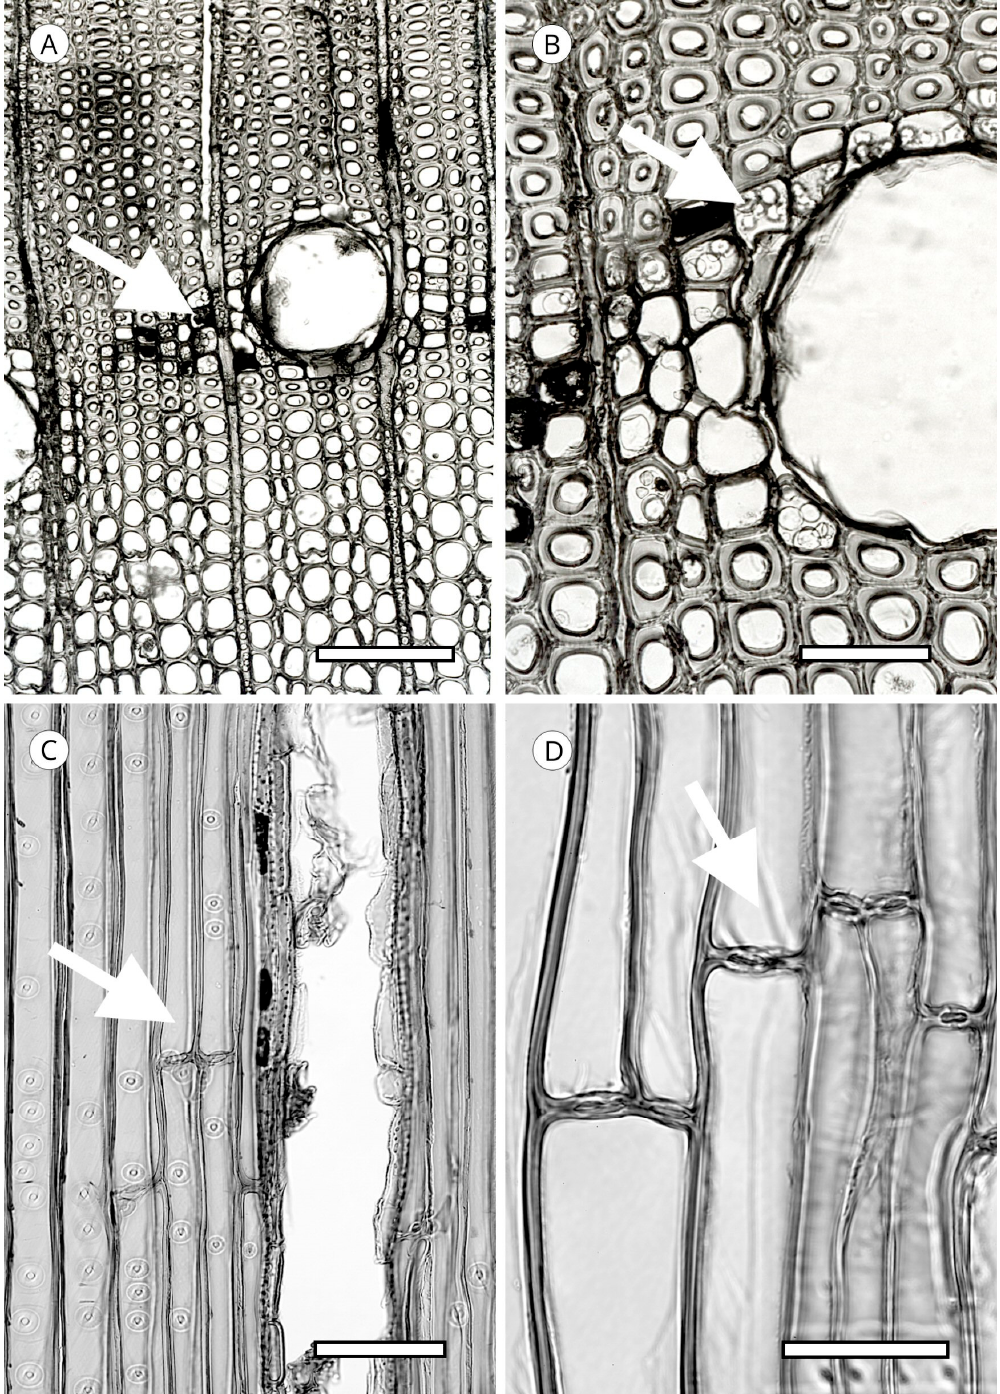
Figure 38. Resin canal subsidiary cells. ( A , B ) Parenchyma cells with starch content in Pinus canariensis C.Sm. ex DC.; ( C , D ) Strand tracheids in Picea glehnii (F.Schmidt) Mast. Scale bars. ( A ) = 350 µ m; ( B – D ) = 100 µ